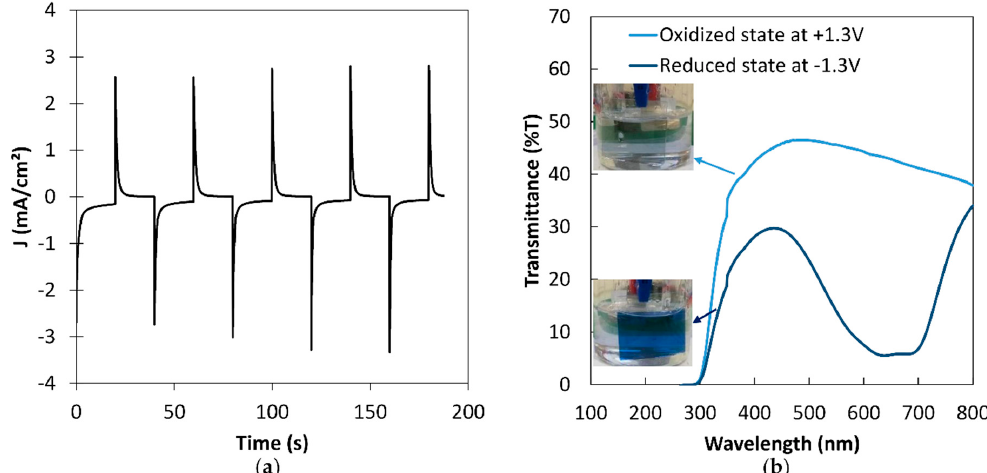
Figure 4. ( a ) Chronoamperograms in a three-electrode cell configuration at − 1.3 V for 20 s and +1.3 V for 20 s of the PEDOT:PSS layer at the optimized thickness of 880 nm, ( b ) corresponding optical transmittance spectra at oxidized and reduced states of PEDOT:PSS layer at the optimized thickness of 880 nm (the pictures of the thin films during the test are presented in the inset).